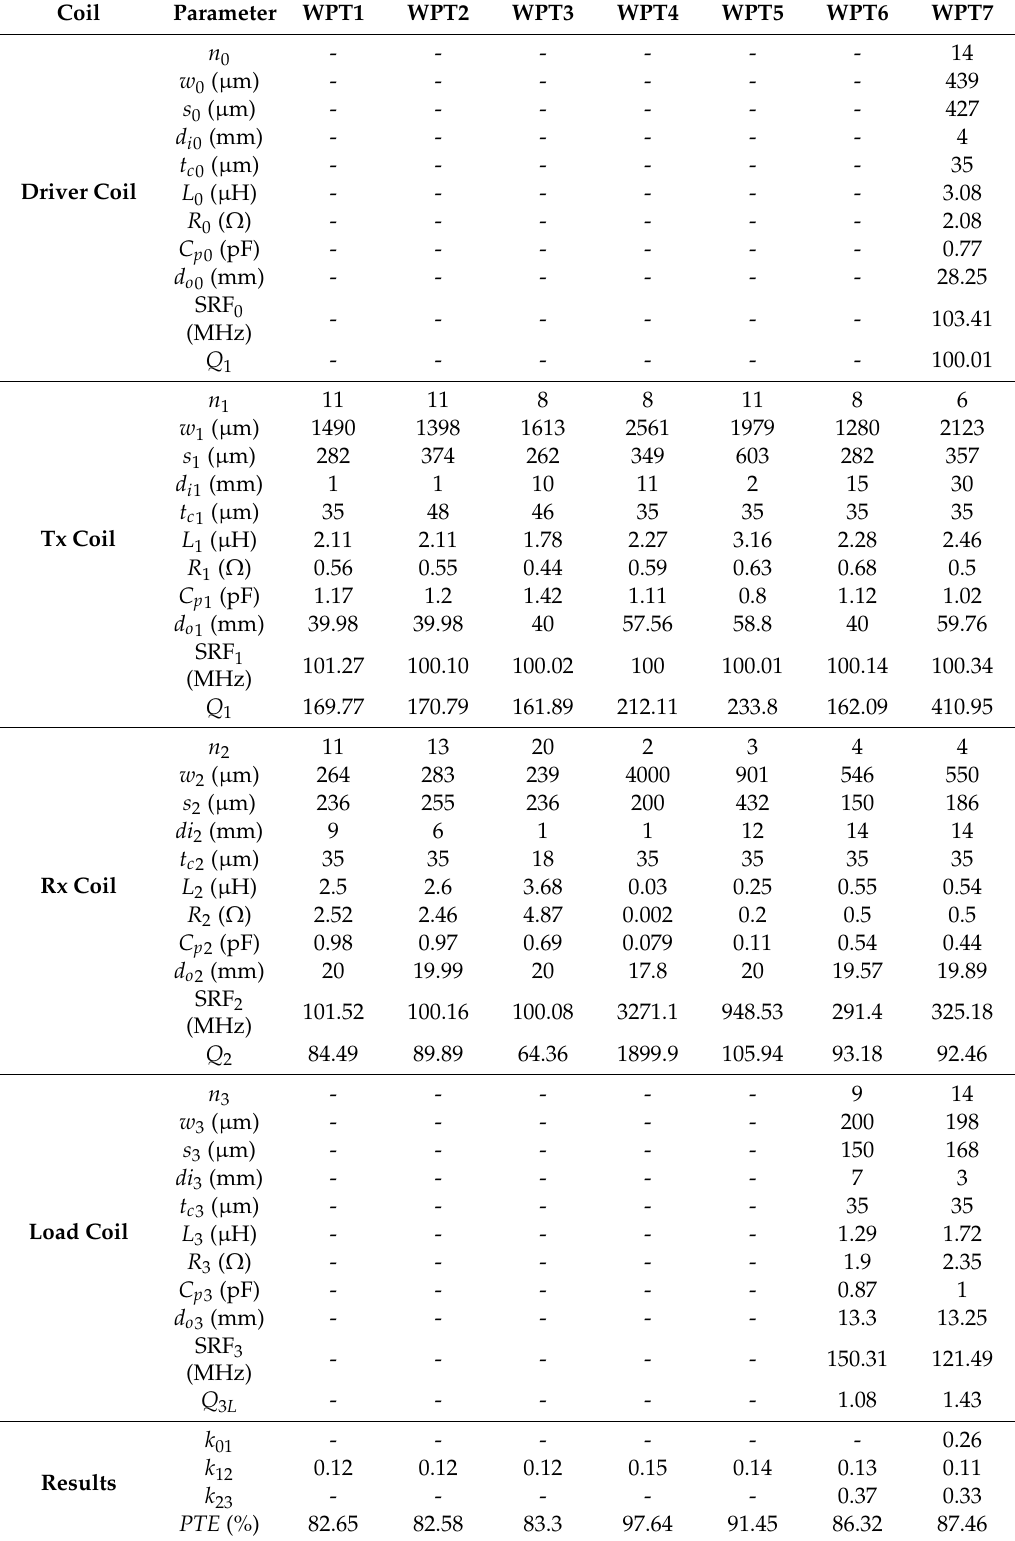
Table 2. Results of optimizing the geometries of the printed spiral coils using the proposed optimization